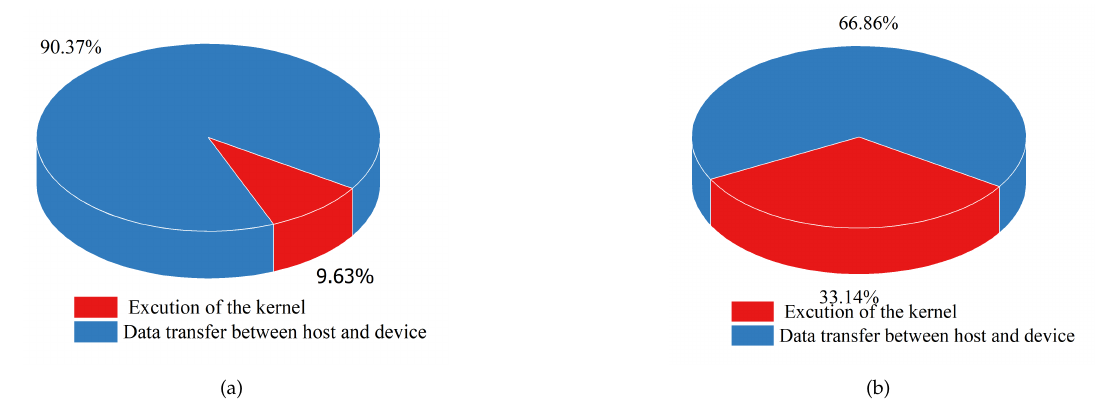
Figure 9. Proportion of kernel calculation and data transmission time. ( a ) Without the CUDA stream for optimization. ( b ) Optimization after using CUDA stream.